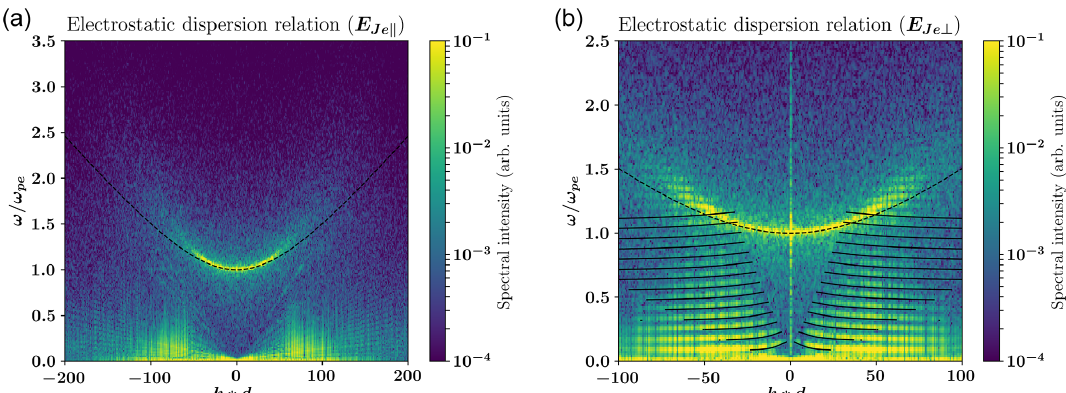
Figure 4. Dispersion analysis of the electron solver in a 1D test case with an axis-parallel (a) and axis-perpendicular (b) magnetic field. The colour map shows the spatio-temporal Fourier transform of E J wave (black dashed curve) and Bernstein modes (black solid